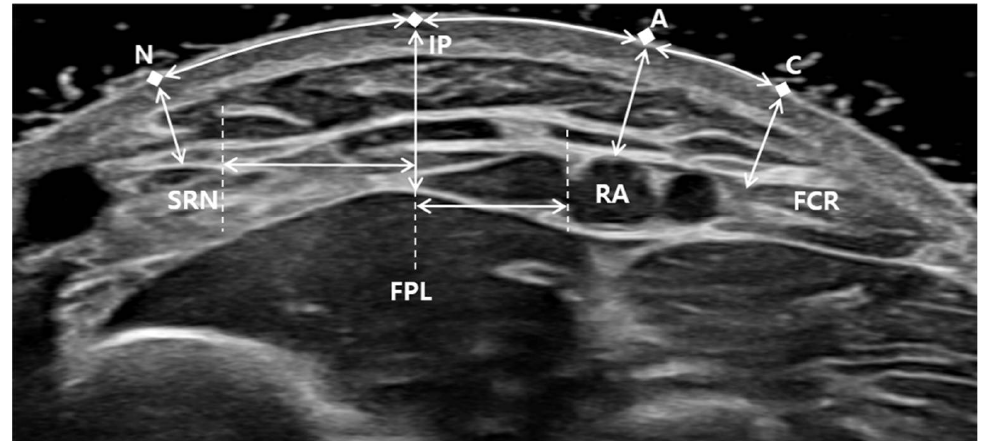
Figure 2. Transverse view of ultrasonographic image of the forearm at the distal third of the forearm. N, skin surface point from SRN; IP, preliminary needle insertion point; A, skin surface point from RA; C, skin surface point from FCR; RA, radial artery; SRN, superficial radial nerve; R, radius; FPL, flexor pollicis longus; FCR, flexor carpi radialis.